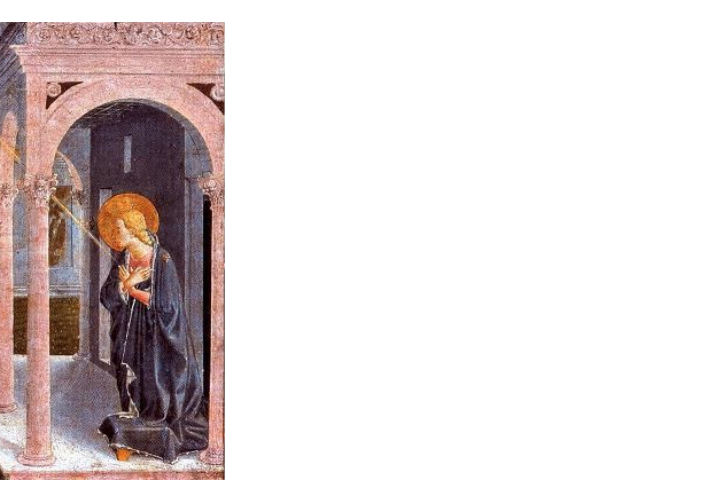
Figure 6. Benozzo Gozzoli, The Annunciation , c. 1445. A scene of the predella of the Madonna della